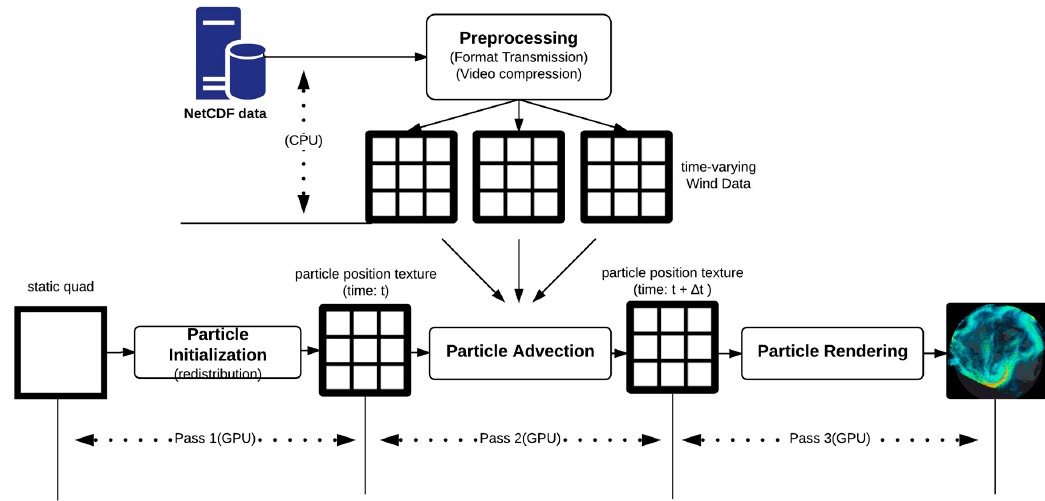
Figure 7. The workflow of particle-based wind data visualization. Three phrases of particle computing are executed on GPU.